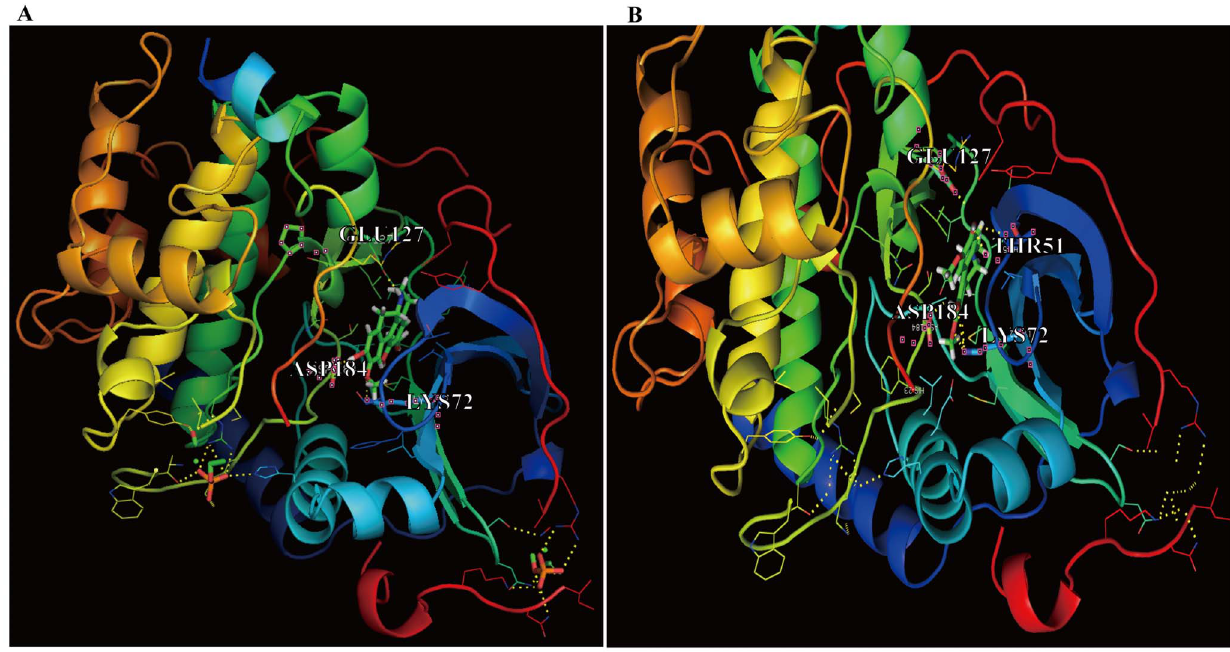
Figure 9. Computational structure prediction for PKA and docking simulations with NOR. Docking simulation results between the 3D structure of PKA and the chemical structures of (A) NOR-S (viridis color) and (B) NOR-R (viridis color). Docking simulations were performed using AutoDock4.2. The docking score of NOR-S and NOR-R were 5.06 and 4.96, respectively. The yellow dotted lines represent possible hydrogen bonds. GLU127, ASP184, LYS72 of PKA were predicted to hydrogen bond to NOR-S, and THR51, GLU127, ASP184, LYS72 of PKA were to